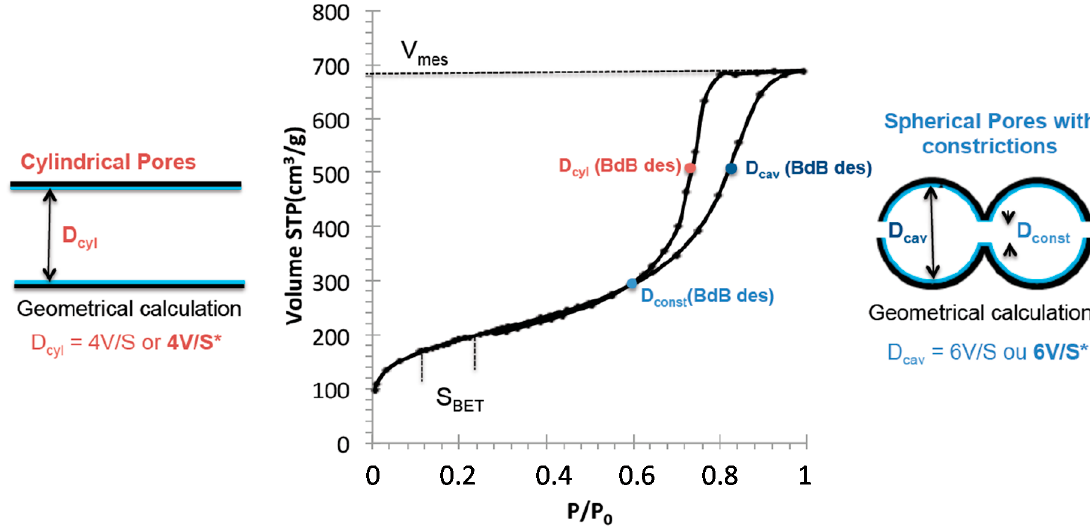
Figure 7. Schematic representation to explain how to measure mesopore size in the case of cylindrical and spherical shape of mesopores.